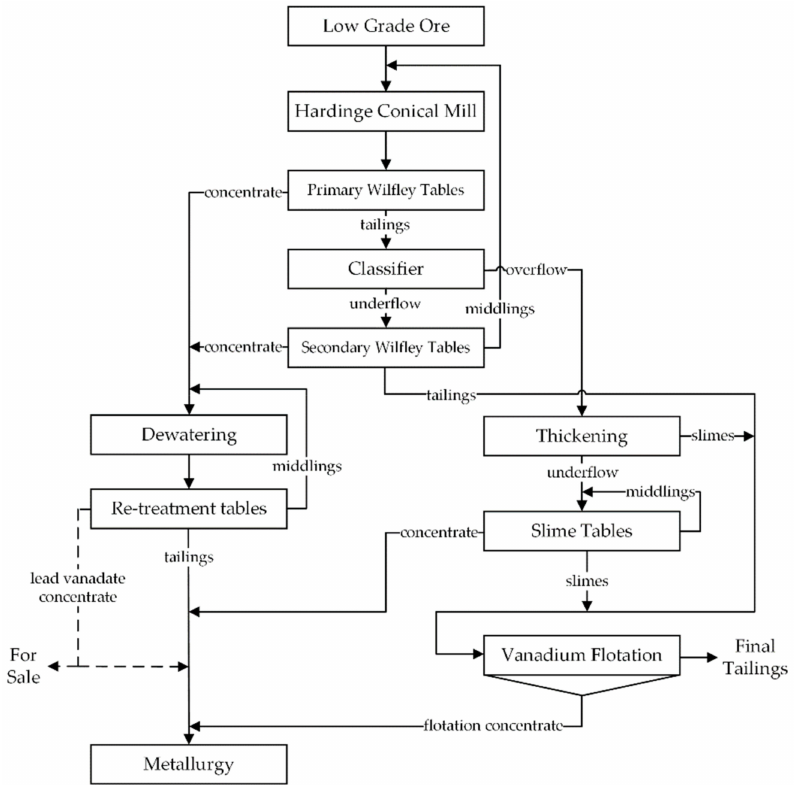
Figure 4. Flowsheet of the vanadium processing plant at Kabwe, Zambia (modified from